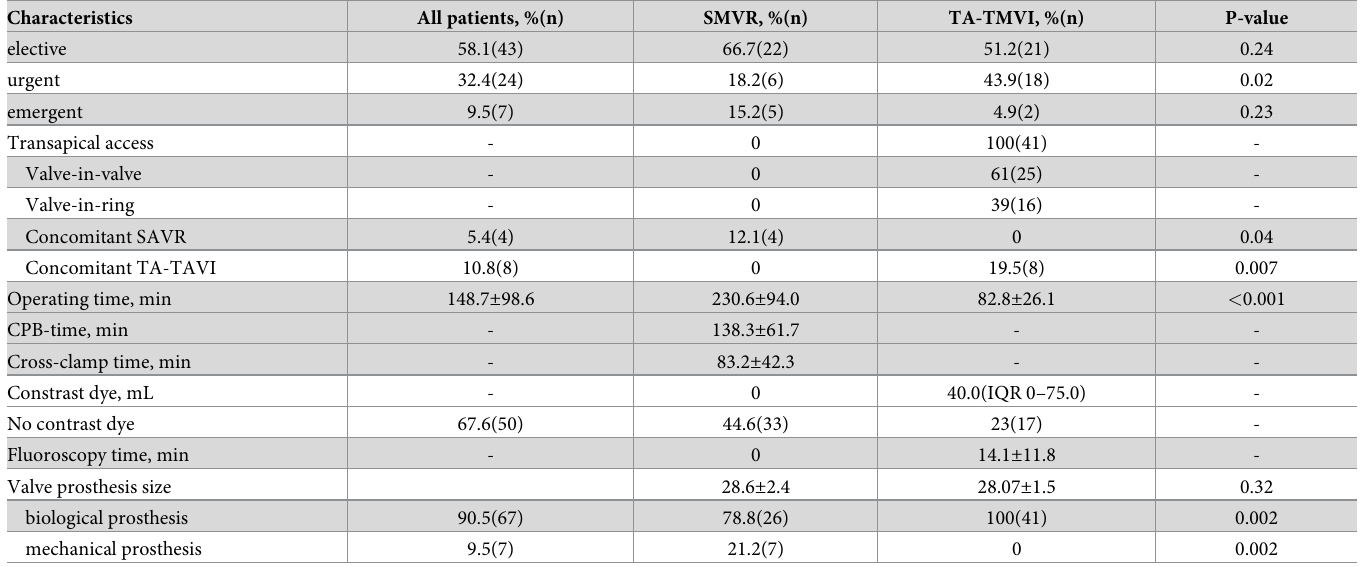
Table 2. Intraoperative